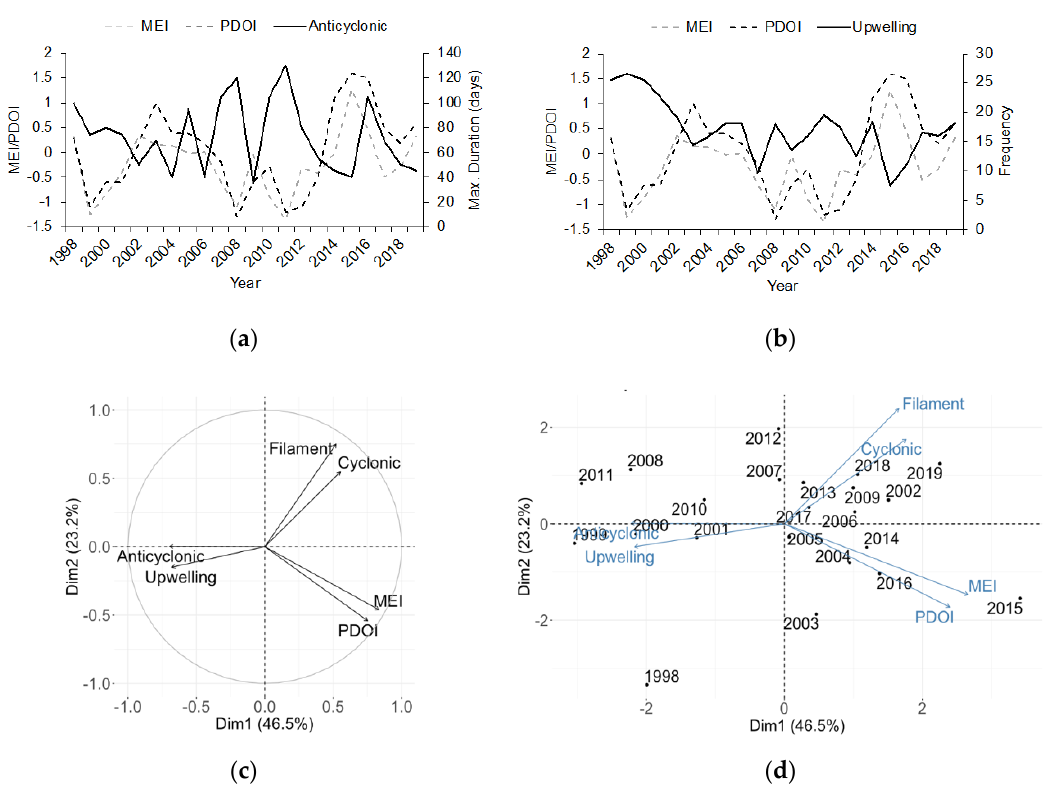
Figure 11. The Multivariate El Niño Index (MEI) and the Pacific Decadal Oscillation Index (PDOI) with the interannual variability in the Northern Gulf of California of ( a ) anticyclonic eddies maximum duration and ( b ) coastal upwelling frequency. Principal component analysis of oceanic mesoscale events, the Multivariate El Niño Index and the Pacific Decadal Oscillation Index in the Northern Gulf of California; ( c ) Contribution of mesoscale events and climate indices to the first two principal components; ( d ) Contribution of each year (1998–2019) to the first two principal